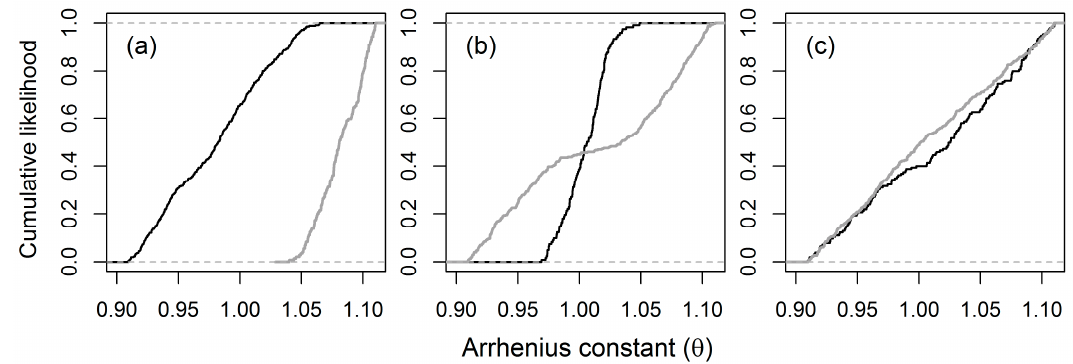
Figure 7. Cumulative density functions of behavior and non-behavior solutions based on the NSE likelihood functions for ( a ) ammonia (NH 3 -N), ( b ) organic nitrogen (ON), and ( c ) nitrate (NO 3 -N). Black indicates behavioral likelihood (NSE ≥ 0); gray indicates non-behavioral likelihood (NSE <0).